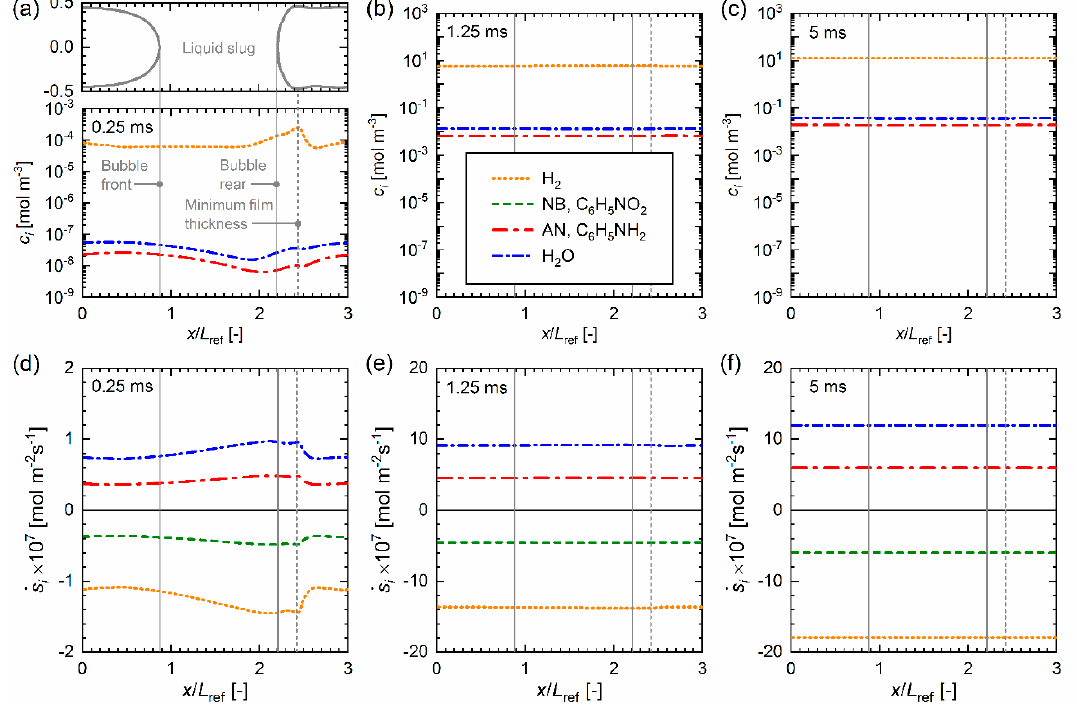
Figure 7. Concentration distributions of bulk species ( a – c ) and production/consumption rates at the catalytic surface ( d – f ) at t = 0.25 ( a , d ), 1.25 ( b , e ) and 5 ms ( c , f ). For legend, see inset in subfigure ( b ).